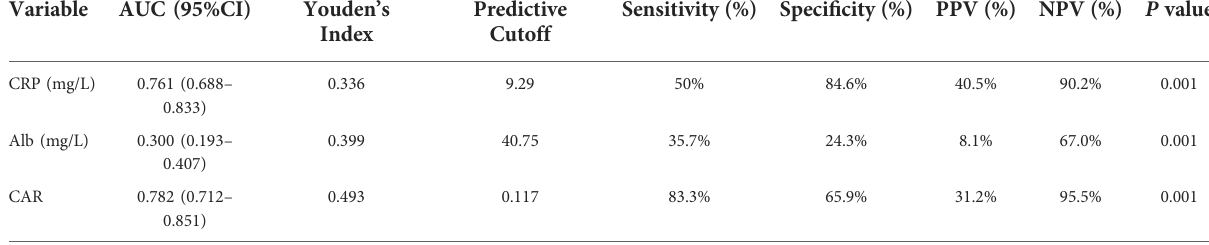
TABLE 3 Comparison of the AUC for the three in fl ammation-based prognostic scores. Variable